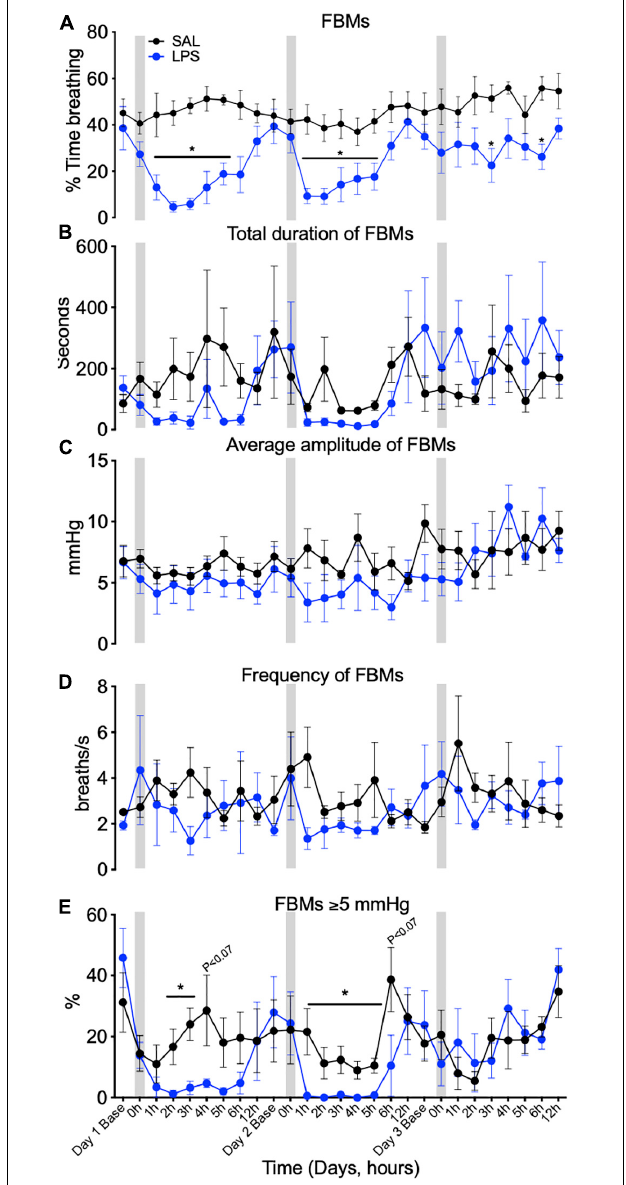
FIGURE 2 | Fetal breathing movements (FBMs) measured across 3 days at baseline (1 h before SAL/LPS infusions), 0 h (the hour of SAL/LPS infusion), + 1, 2, 3, 4, 5, 6, and 12 h epochs following saline (SAL) and LPS infusions. Percentage of time fetuses spent breathing (A) , total duration of FBMs (B) , average amplitude of FBMs (average depth of breaths during each 1-h epoch, C ), frequency of FBMs (average number of breaths/second during an episode of FBMs over each 1 h epoch, D ), and percentage of vigorous fetal breathing TABLE 1 | Fetal characteristics. * P < 0.05 vs control (SAL). movements ≥ 5 mmHg (E) in SAL (control = black) and LPS-exposed (blue) fetuses. Gray bars indicate SAL or LPS infusion on each day after baseline SAL sampling. Data are means ± SEM, * P < 0.05 vs. control.